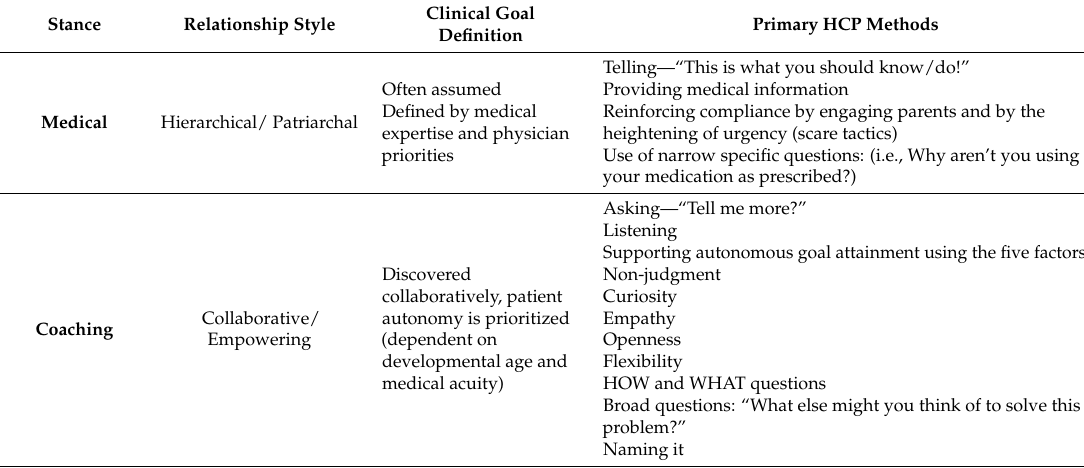
Table 2. Comparison of Medical and Coaching